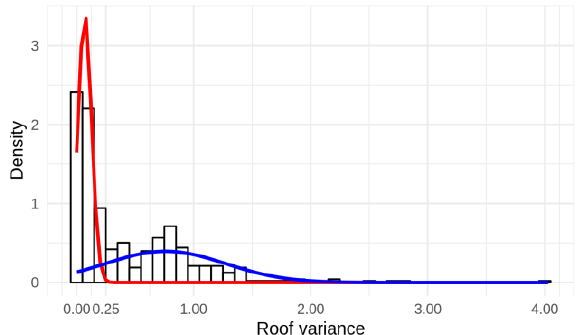
Figure 8. Gaussian Mixture model and histogram of roof variances in the sample data set. Flat roofs (red) and not-flat roofs (blue). Sample size 470 buildings.